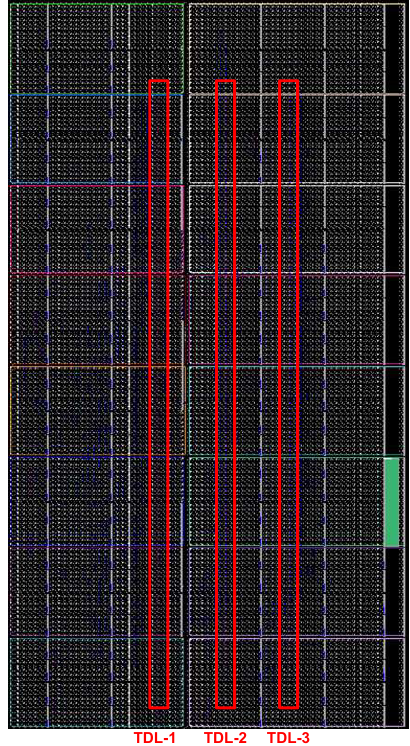
Figure 4. Layout of the three TDLs in the FPGA chip.